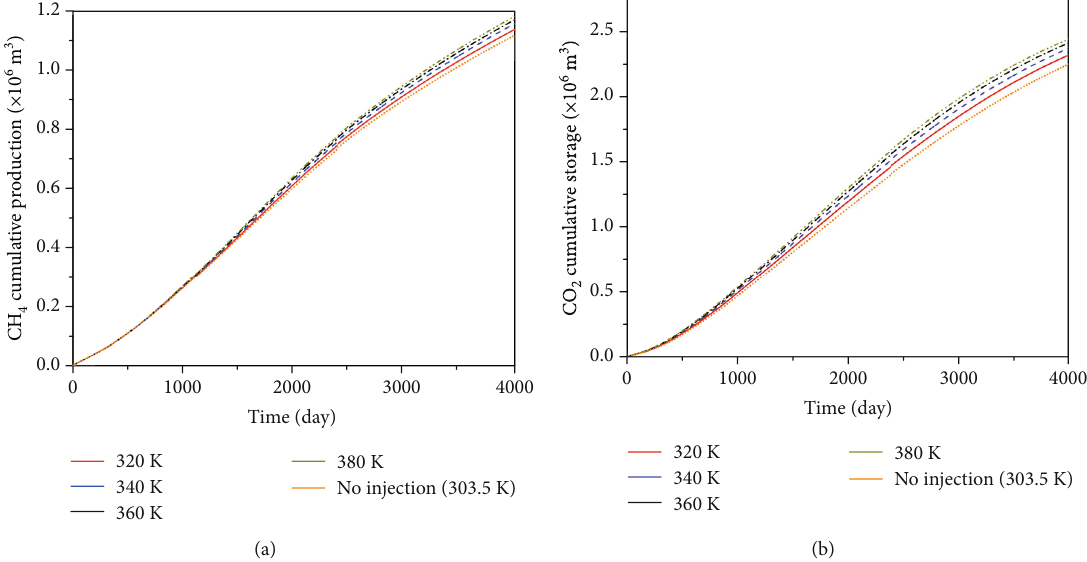
Figure 25: CH cumulative production and CO 4 (b) CO cumulative 2